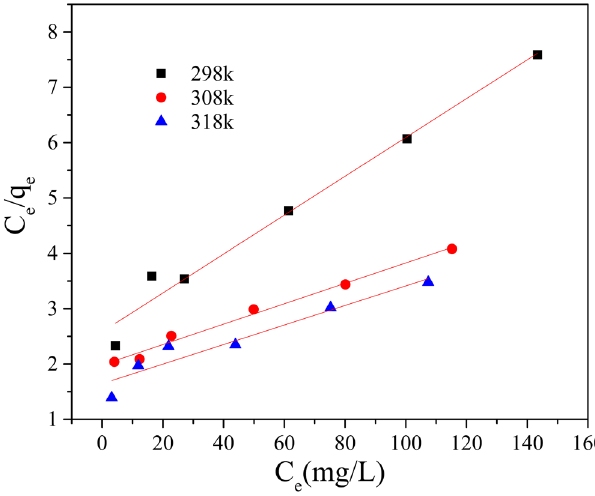
Figure 14. The Langmuir adsorption isotherm.